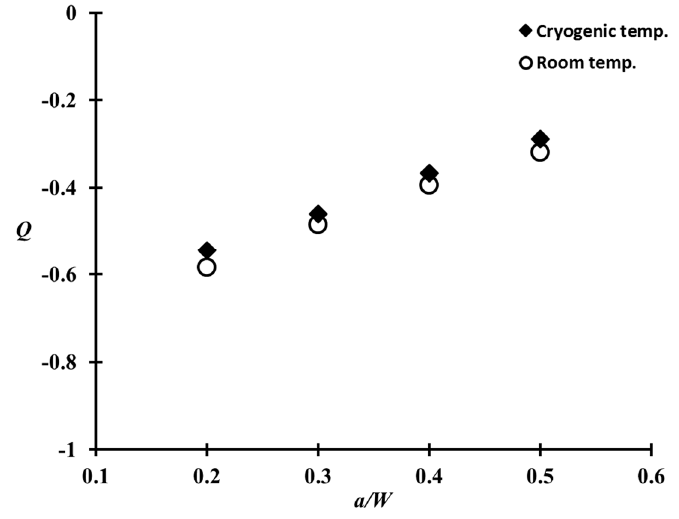
Figure 8. Comparison of the Q parameters for the weldment with respect to different a/W ratios at room and cryogenic temperatures.